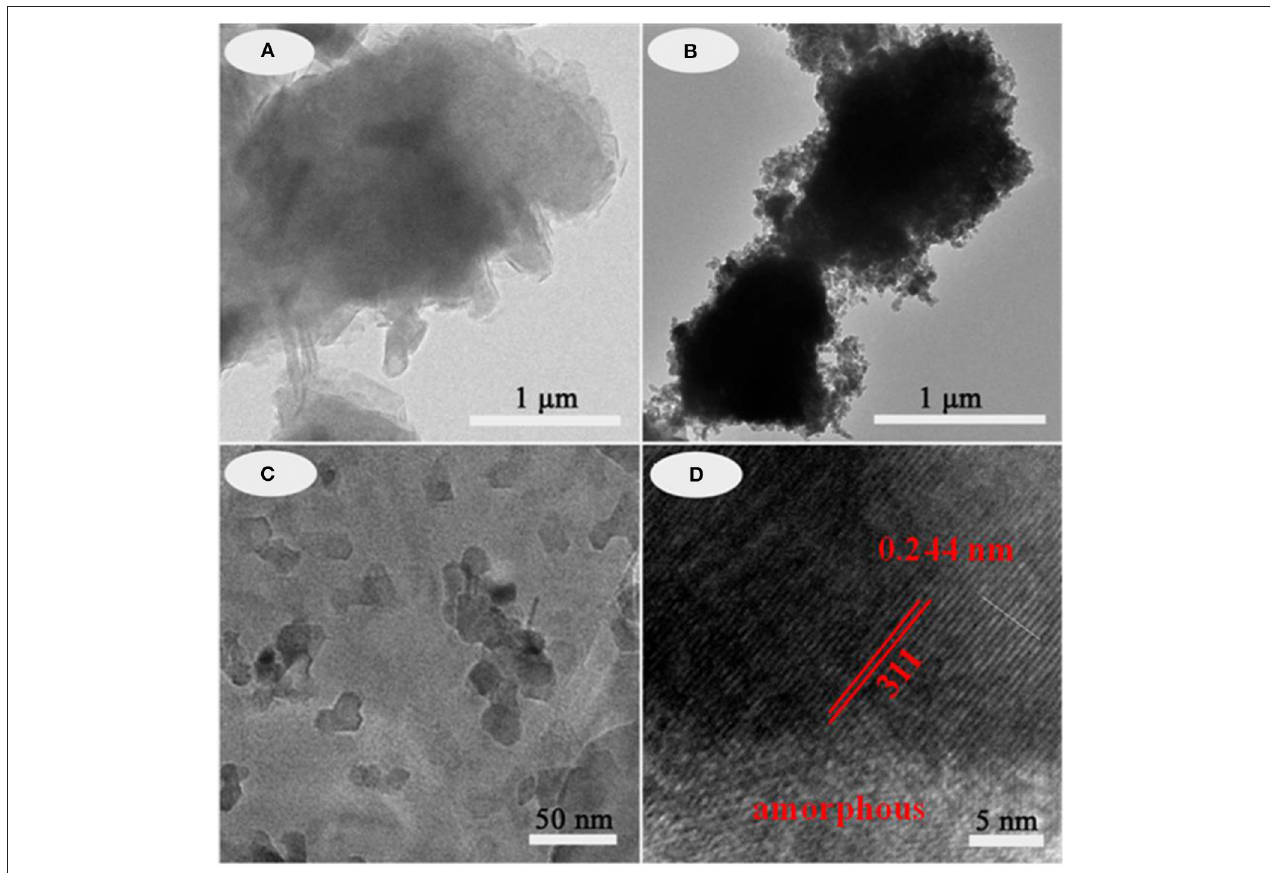
FIGURE 2 | TEM images of (A) Kaol and (B–D) CoAl 2 O 4 /Kaol-1100 ◦ C.